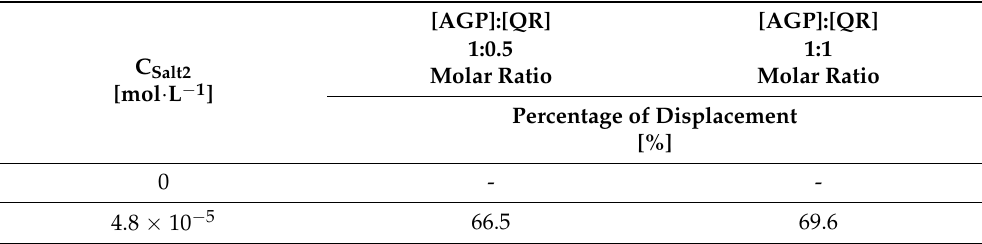
Table 8. The percentage of displacement of QR from the AGP molecule in the presence of Salt2